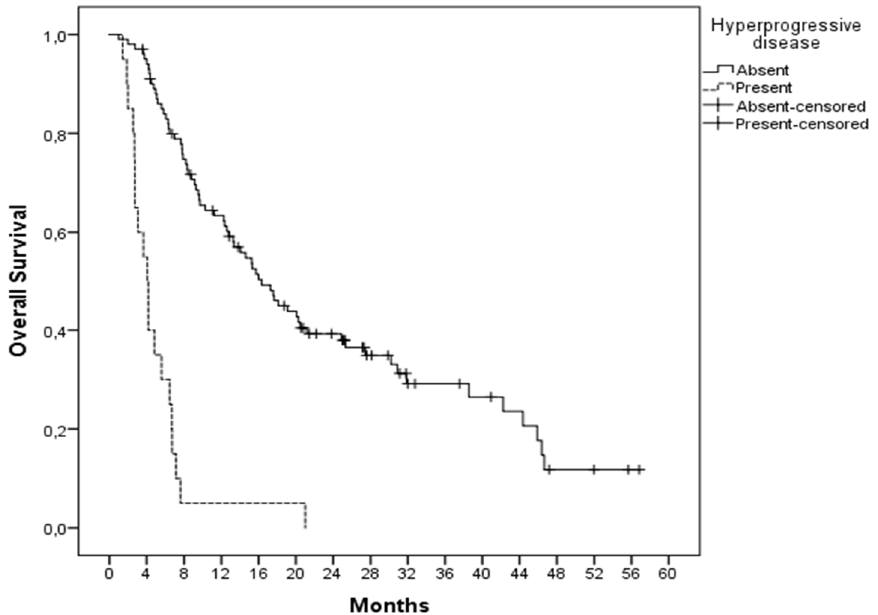
Figure 1. Comparison of overall survival according to the presence or absence of hyperprogression.